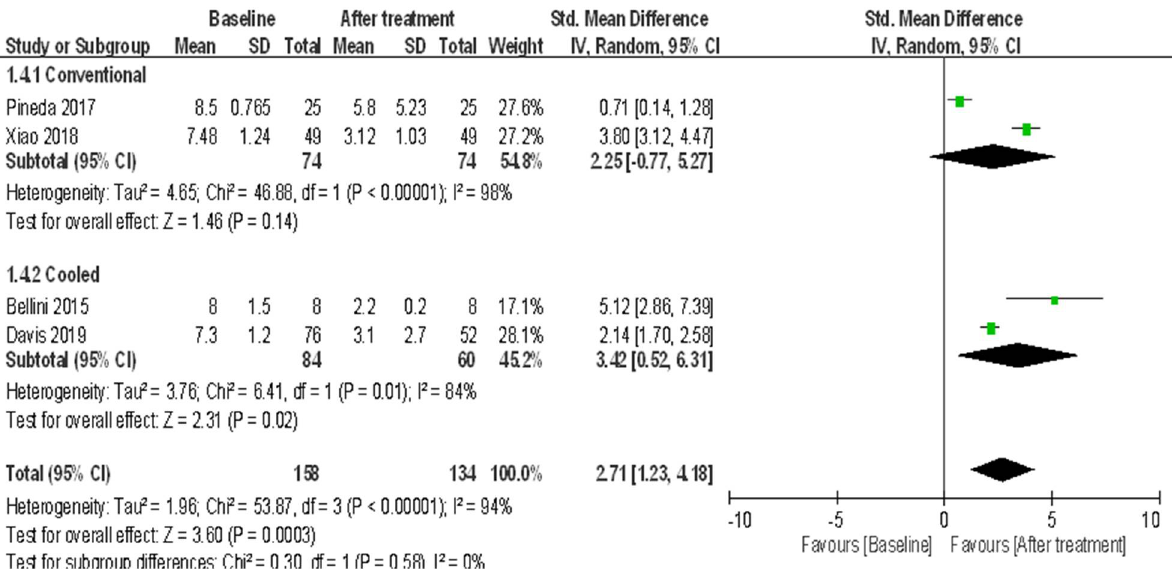
Figure 4. Meta-analysis of efficacy in pain using three radiofrequency ablation techniques to treat knee OA at the 6-month follow-up.